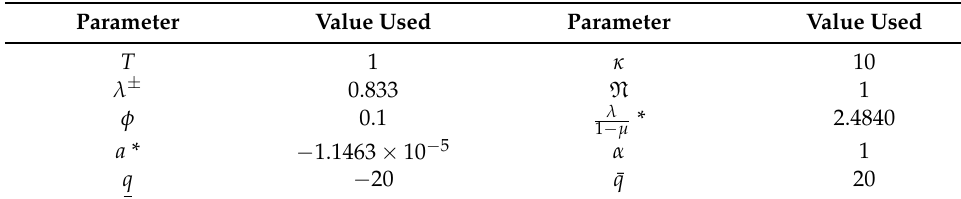
Table 8. Market-making parameters for Apple stock.